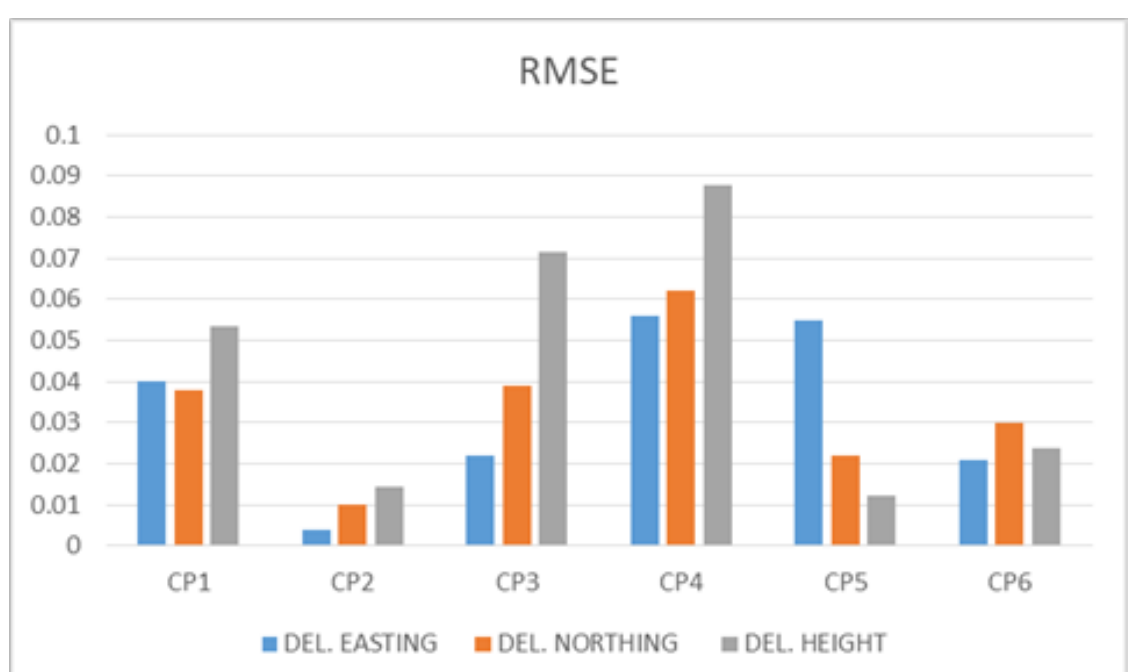
Figure 10 Error for each CP in horizontal and vertical